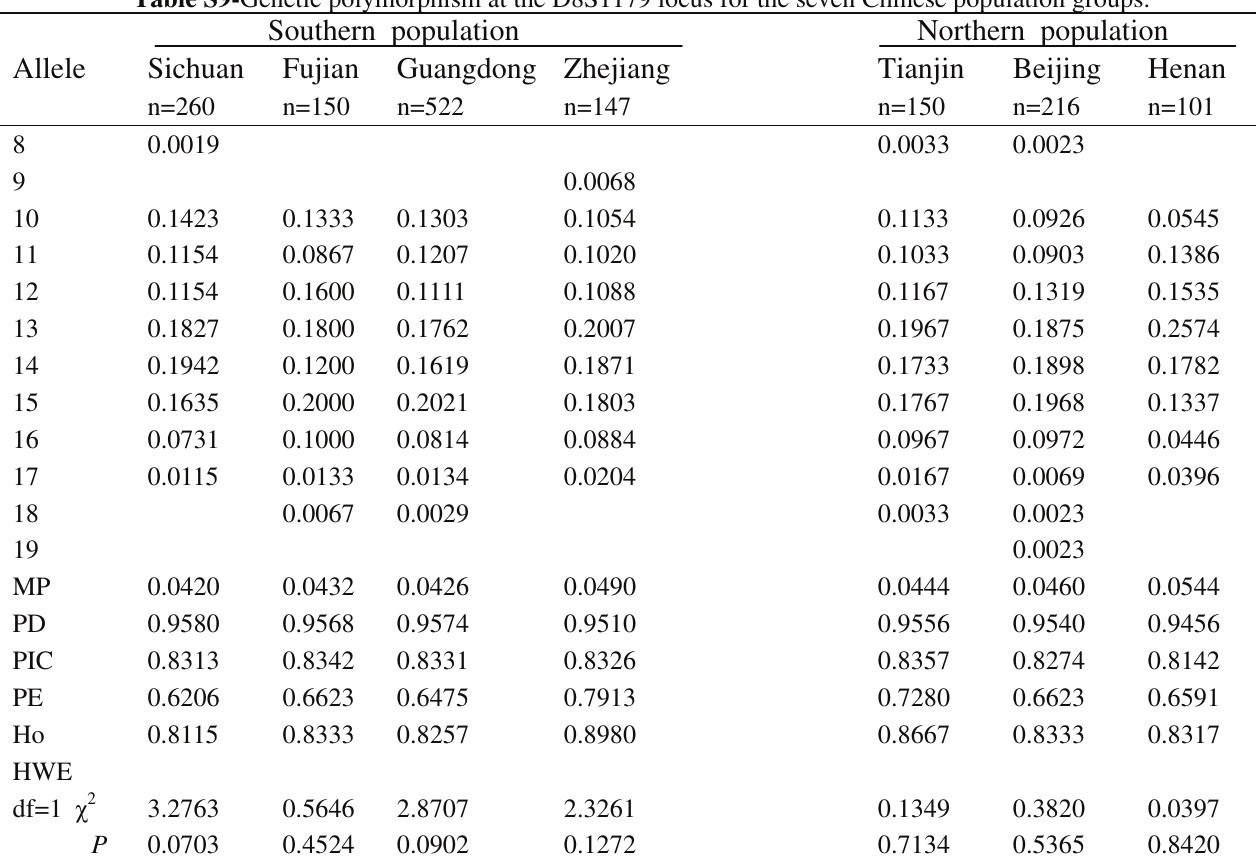
Table S9- Genetic polymorphism at the D8S1179 locus for the seven Chinese population